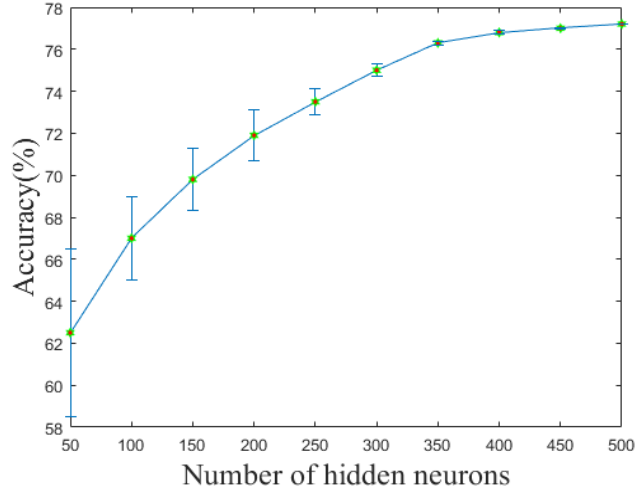
Figure 4. Aircraft recognition performance under different numbers of hidden neurons.